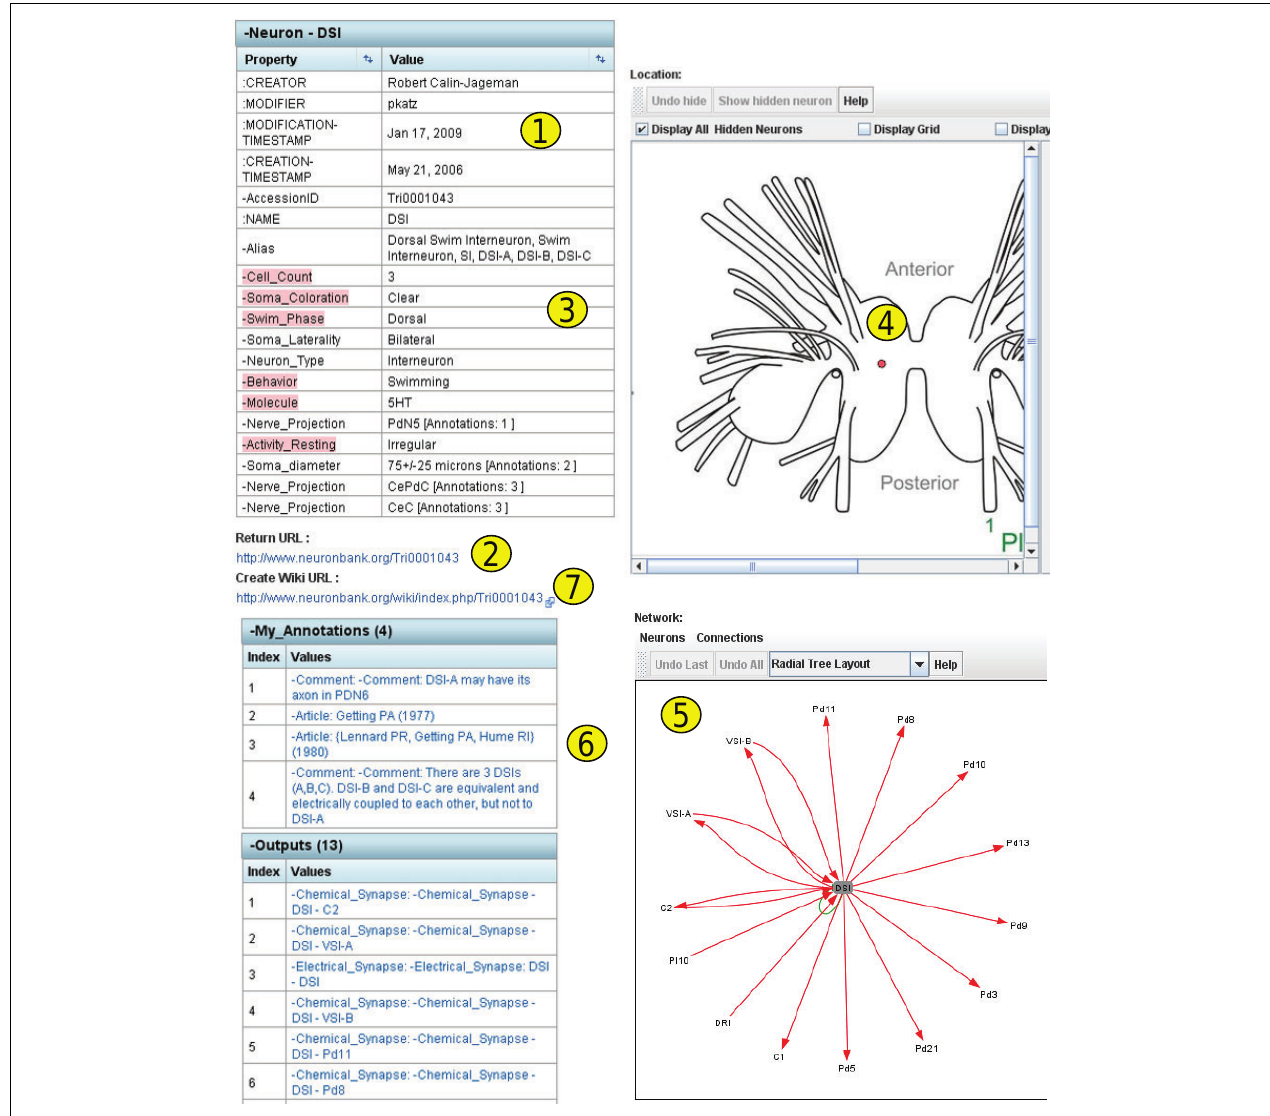
FIGURE 8 | Detail page dynamically generated for